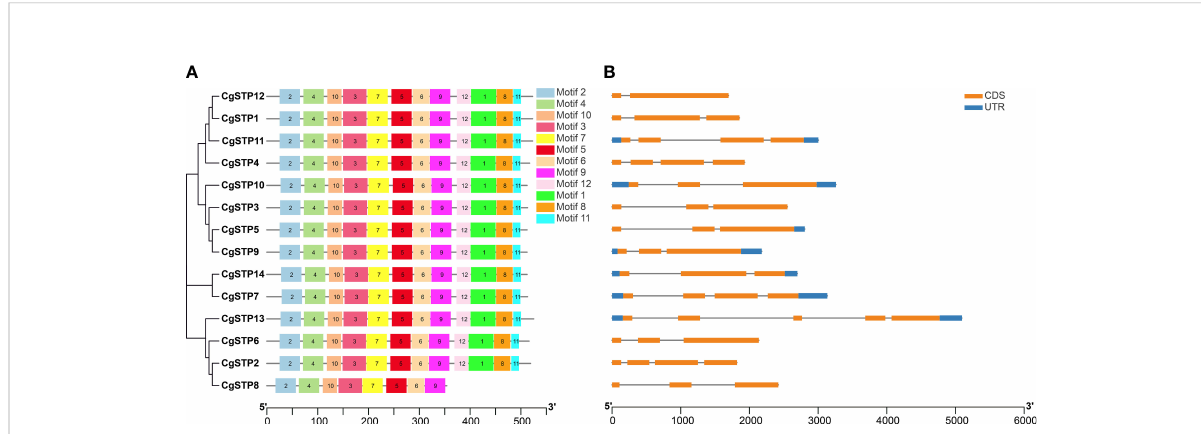
FIGURE 2 Motif, gene structure and phylogenetic relationship analysis of CgSTP genes. (A) The motif analysis was performed on the MEME. Twelve motifs were identi fi ed. The detail of motif sequence information was presented in Supplemental Table 2. (B) The gene exon – intron structure analysis. The blue color was the untranslated region, while the orange was the coding sequence. The line without color referred to introns. The neighbor-joining phylogenetic tree of the CgSTP genes sequences was constructed using 1000 bootstrap replicates by